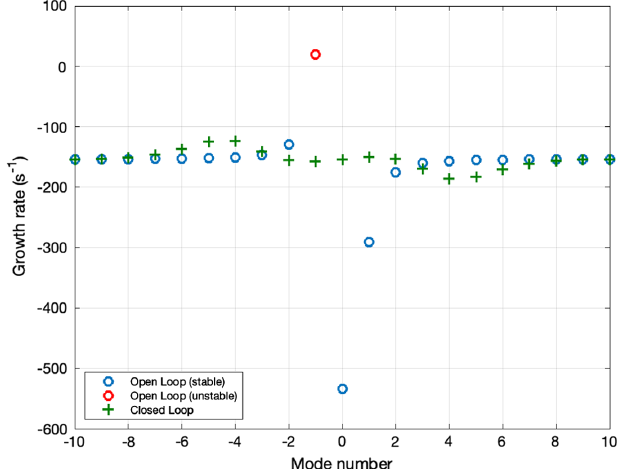
FIG. 20. Growth rate estimates for 10 GeV electron ring.